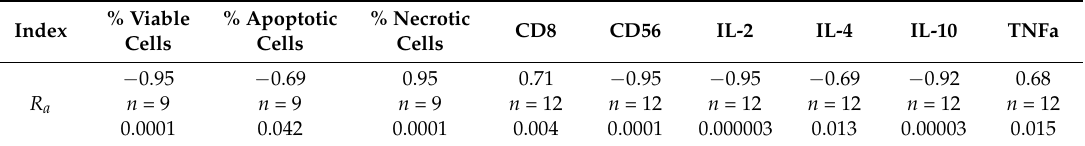
Table 6. Spearman’s correlation coefficient between the R a of the TiO 2 coating and the morphofunctional parameters of the Jurkat T cell cultures.